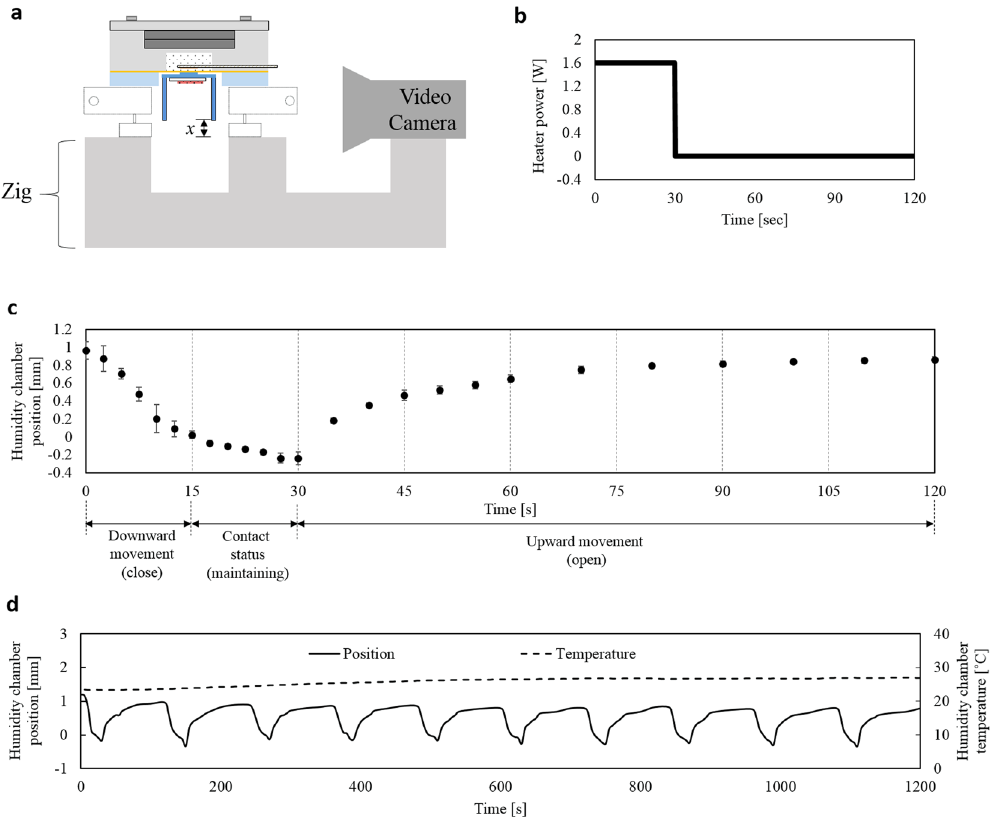
Figure 4. Characterization of the thermo-pneumatic actuation of the humidity chamber: ( a ) experimental setup; ( b ) the input power train, composed of the heater power of 1.6 W for 30 sec and 0 W for 90 sec, for the one cycle humidity chamber movement; ( c ) time-dependent humidity chamber position for the input power train of Fig. 4b; (d) time-dependent humidity chamber position and temperature inside the humidity chamber for the ten cycle of the operation of Fig.